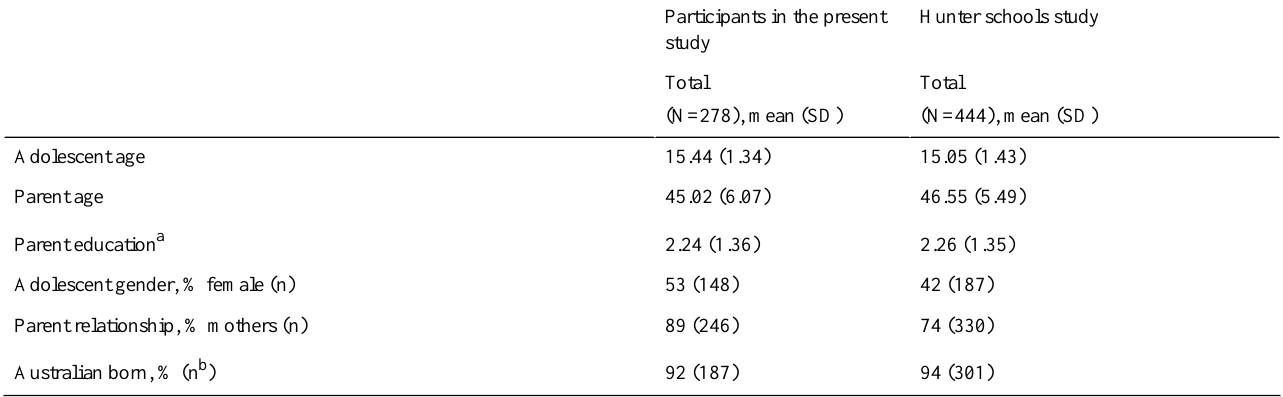
Table 1. Characteristics of parents in this study compared with parents recruited by post and email from Hunter schools in a separate study (assessing sample